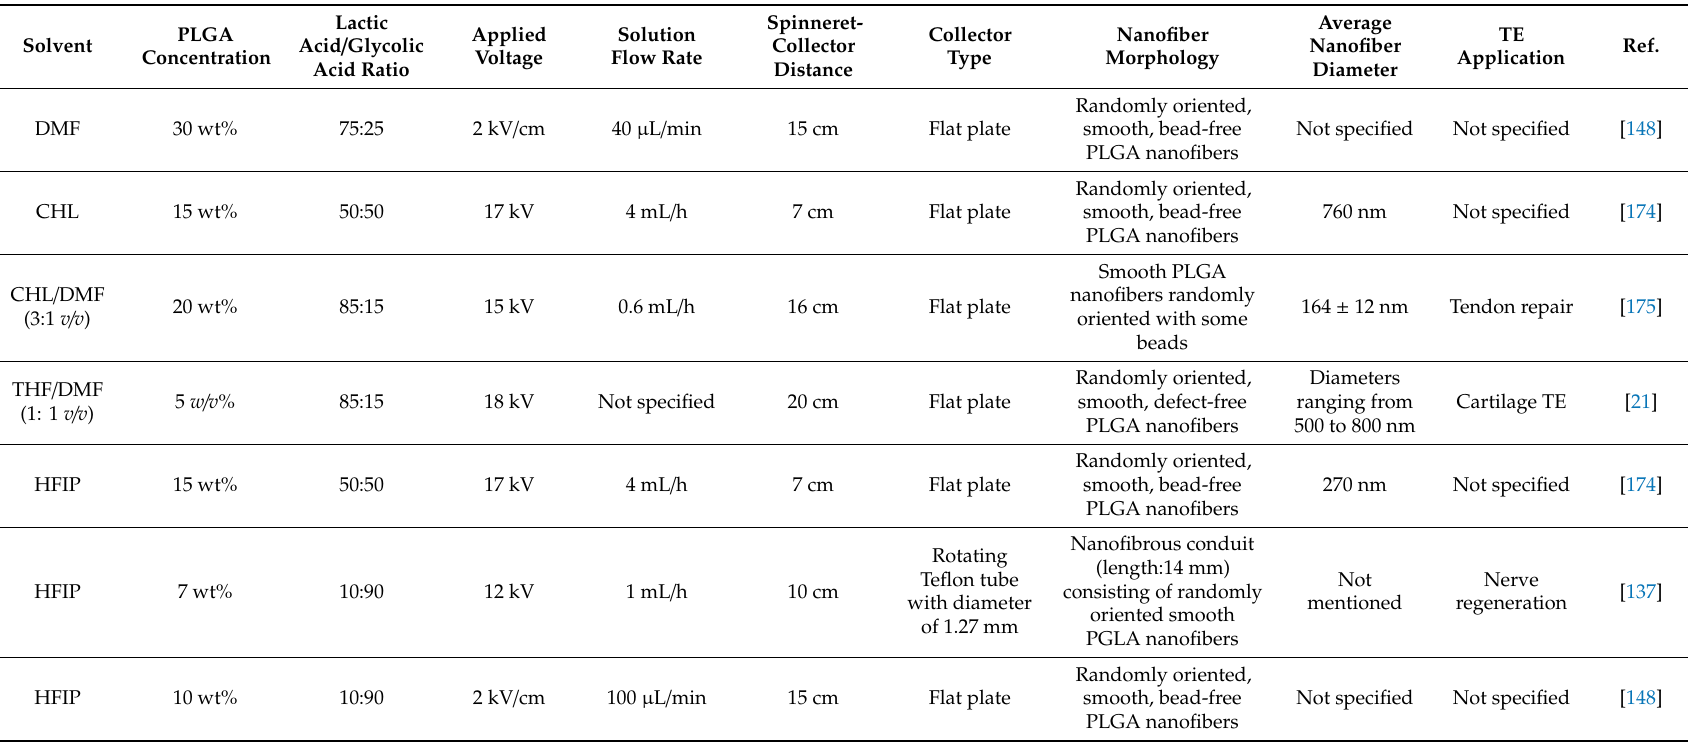
Table 5. A selection of PLGA nanofibrous TE sca ff olds obtained using solvent